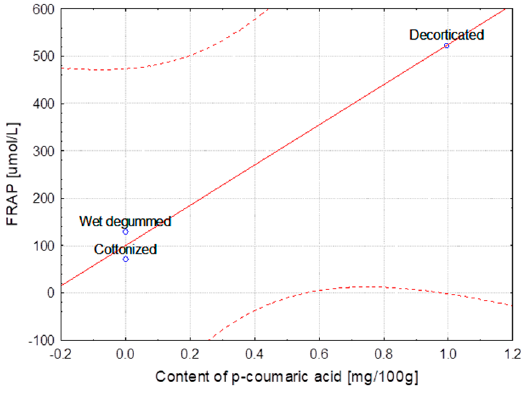
Figure 5. Variety of flax MODRAN—Dependence of FRAP [ μ mol/L] vs. content of p -coumaric acid [mg/100 g] (y = 100.070 + 425.055x; C = 95%).